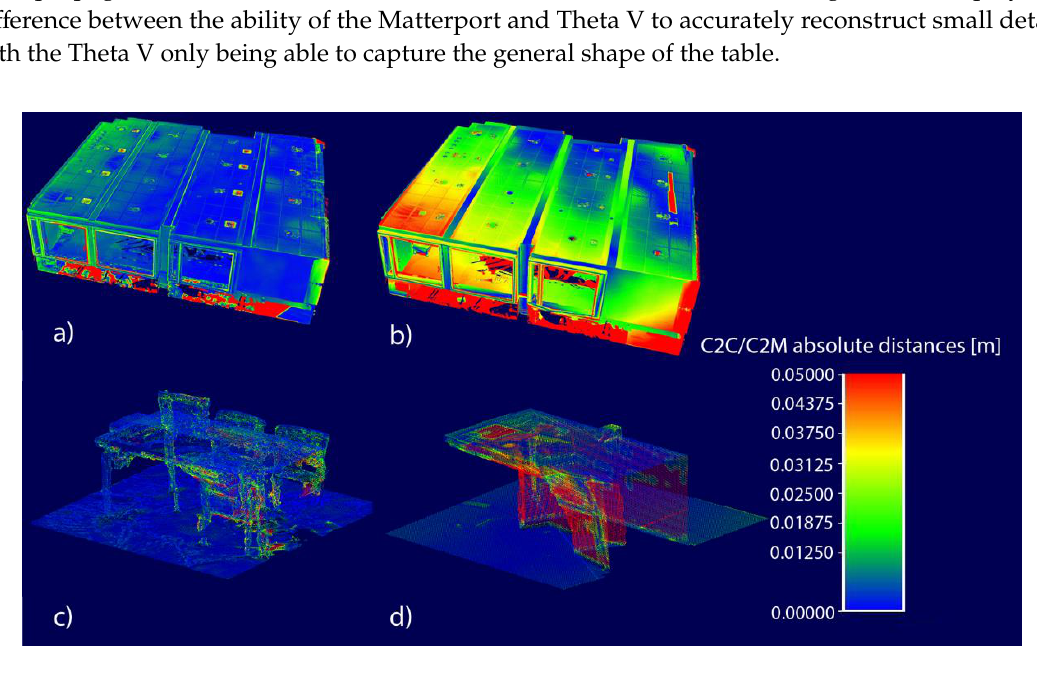
Figure 3. From the hall 101 data, C2M distances of the Matterport-processed BLK360 ( a ) and Theta V ( b ) meshes; C2C distances of the Matterport ( c ) and Theta V ( d ) segment point clouds.